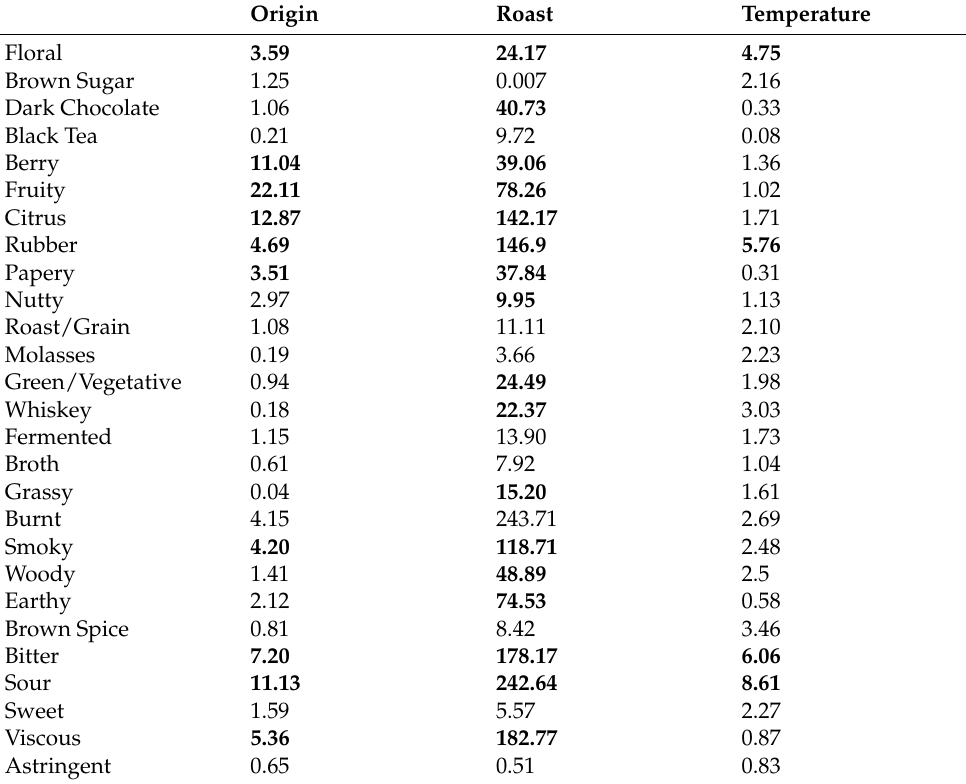
Figure 3. The mean titratable acidity of all brews, with LSD letter codes to indicate significant difference. Table 3. The F values for the experimental factors in the five-way ANOVAs, bolded to indicate significance and adequate panel agreement calculated by pseudomixed